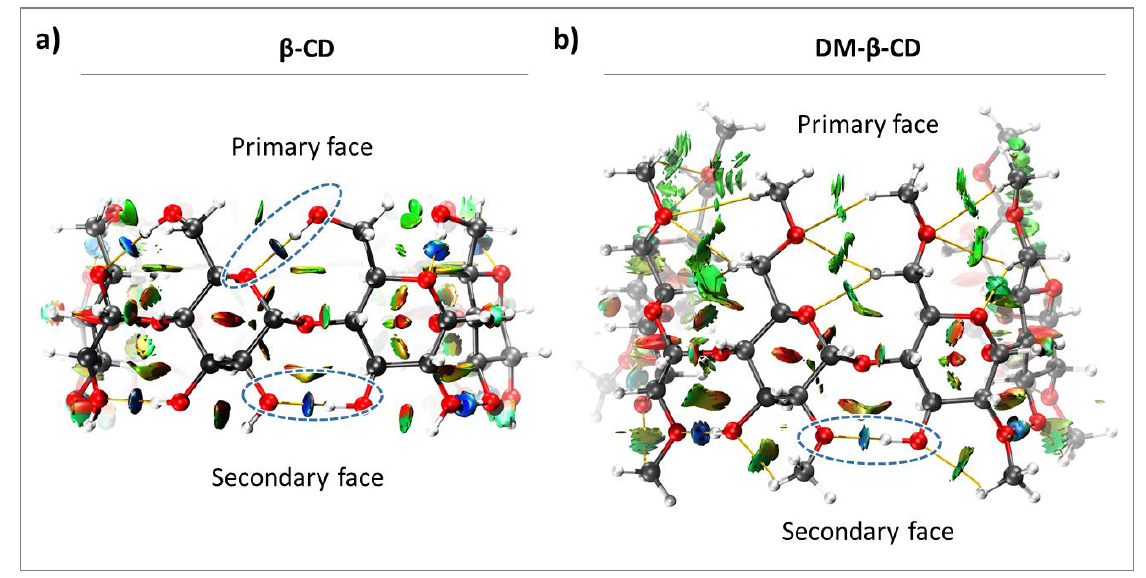
Figure 2. Color-filled RDG isosurface for intramolecular interactions within ( a ) β -CD and ( b ) DM- β -CD . The different types of interaction regions are highlighted, blue: attractive interactions (hydrogen bonds), green: slightly attractive vdW interactions, red: repulsive steric interactions. Hydrogen bonds are additionally marked with blue, dashed ellipsoids.